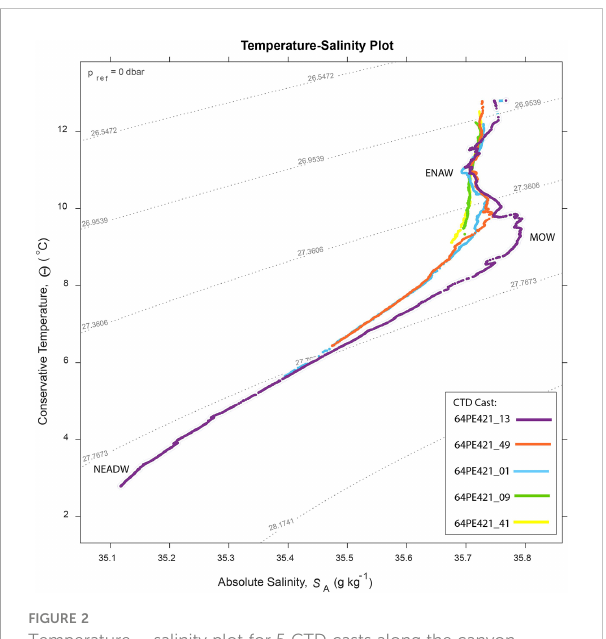
FIGURE 2 Temperature – salinity plot for 5 CTD casts along the canyon branch axis, collected during the 64PE21 cruise. See Supplementary Materials Figure 5 for CTD locations. The in fl uence of the MOW decreases toward the head of the